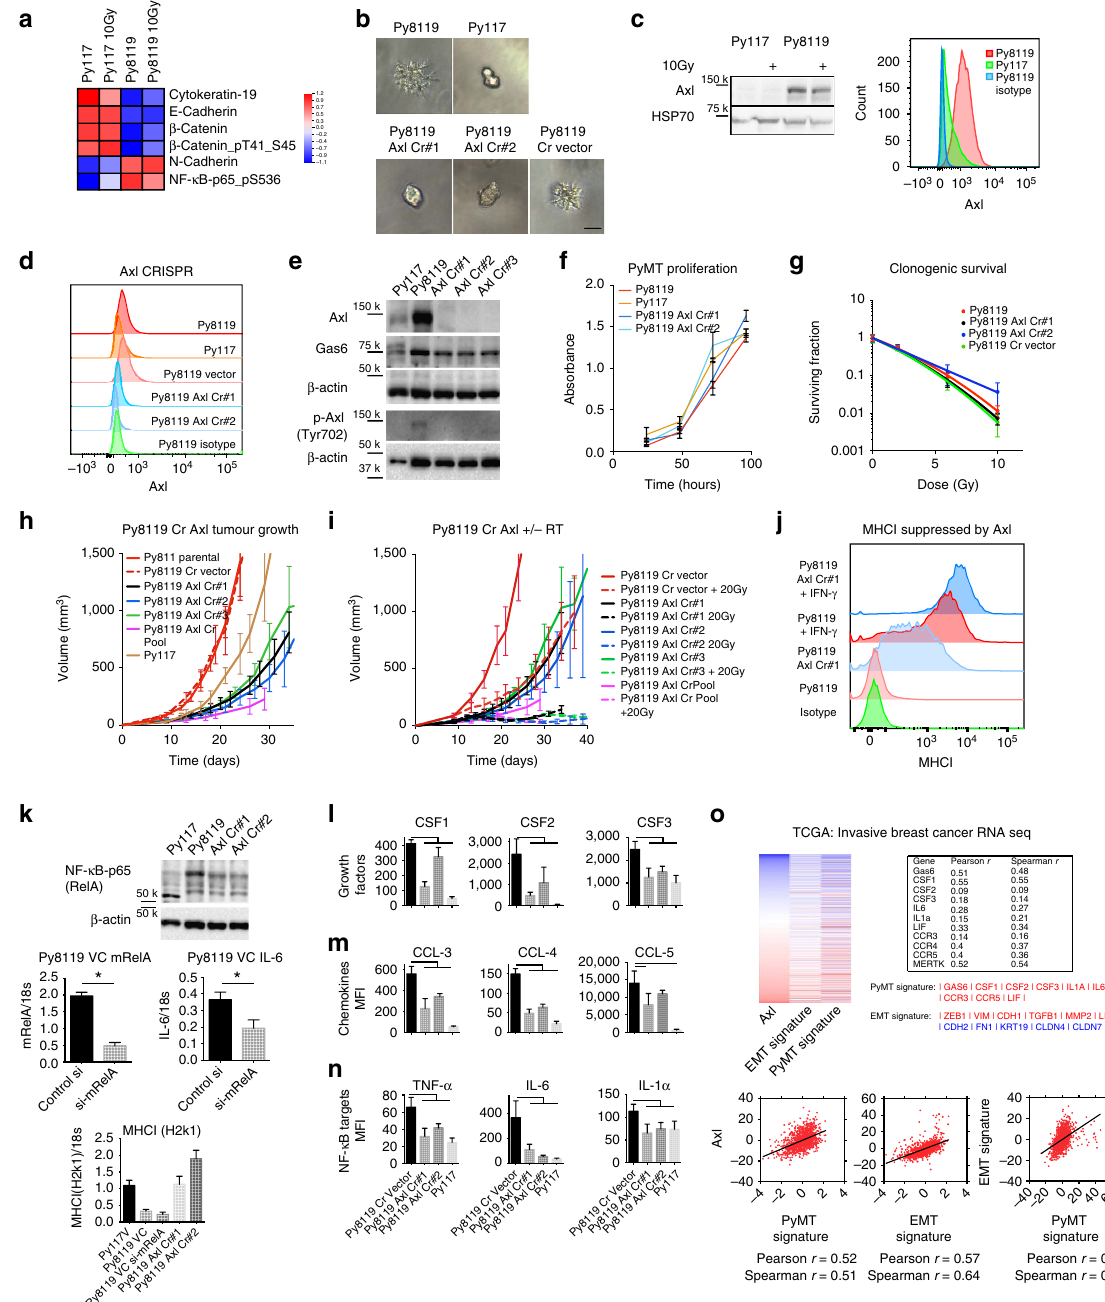
Figure 4 | Axl impacts key immunosuppresive immunological factors in tumour cells. ( a ) The Py8119 cells have an EMT pattern on RPPA and ( b ) are more invasive than Py117 cells in 3D culture (scale bar, 50 m m). ( c ) There was elevated Axl compared with Py117 cells with or without 10Gy of radiation on western blot (left), and flow cytometry (right). ( d ) CRISPR knockout of Axl (Py8119 Axl Cr#1/ #2) was confirmed by flow cytometry and loss of Axl resulted in decreased invasion in 3D culture ( b ). ( e ) Western blots confirmed Axl knockout and decreased phospho-signaling in three CRISPR clones. ( f ) There was no difference in proliferation between wild-type and Axl Cr clones (XTTassay, representative experiment, in triplicate) and ( g ) clonogenic survival revealed no difference in intrinsic factors of radiosensitivity (three independent experiments). There was delayed growth ( h ) and enhanced radiosensitivity ( i ) of Axl knockout tumours (three independent clones and pooled) compared with parental, vector control, and Py117 tumours (five mice each, RT: Py8119 ¼ day 9, Axl Cr#1–3 ¼ day 14, and Axl Cr Pool ¼ day 19). ( j ) MHCI surface expression was increased in Axl Cr #1 cells and further induced by IFN- g compared with parental cells. ( k ) NF- k B-p65 protein was decreased in Axl Cr #1 and #2 and siRNA knockdown in Py8119 vector control (VC) cells revealed knockdown of the transcript and NF- k B target IL-6 (triplicate, * P o 0.03 t -test, MHCI ANOVA P o 0.0001). Conditioned media from Py8119 VC, Axl Cr#1/#2, and Py117 cells resulted in decreased myeloid supporting growth factors ( l ), myeloid recruiting chemokines ( m ), and NF- k B targets ( n ) (MFI ¼ mean fluorescence intensity; three independent experiments; analysis of variance P o 0.05 for each molecule, P o 0.03 for pairwise comparison with Py8119 VC. ( o ) RNAseq from the cancer genome atlas breast cancer data set ( n ¼ 1215) revealed a correlation between Axl and proteins decreased in the Axl knockout cells. A PyMTand EMTgene signature was derived that revealed a significant correlation with Axl and each signature (red ¼ positive and blue ¼ negative correlation, all Pearson and Spearman P o 0.0001 except for CSF2 that were 0.0024 and 0.024, respectively). All error bars, mean and s.d. NATURE COMMUNICATIONS|7:13898|DOI: